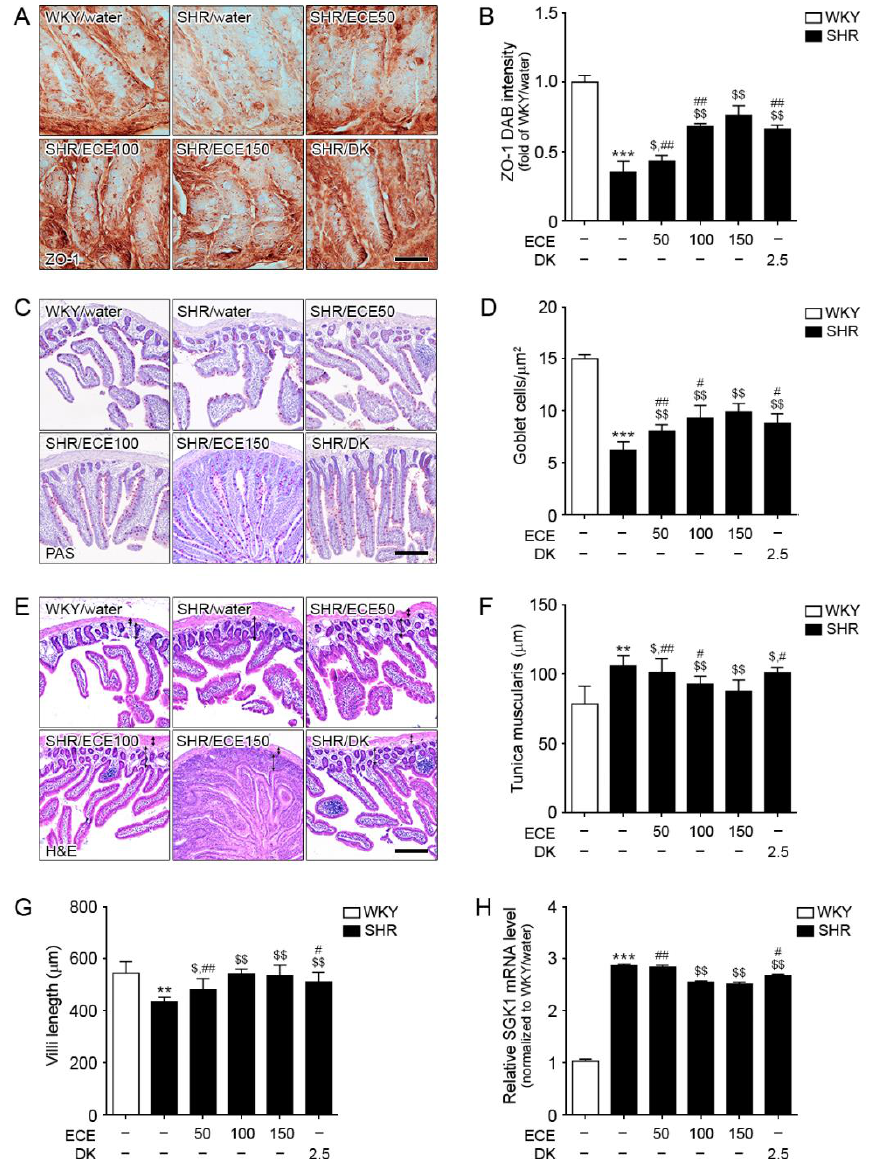
Figure 2. Regulatory effects of DK and ECE on the destruction of gut barrier integrity and SGK1 level in the intestine of SHRs. ( A , B ) The ZO-1 expression level in intestinal tissues was decreased following SHR/water and increased following ECE or DK treatment. ( C , D ) The number of goblet cells in intestinal tissues was decreased following SHR/water and increased following ECE or DK treatment. ( E – G ) The tunica muscularis thickness and villi length in intestinal tissue were measured by H&E staining. ( H ) In intestinal tissues, SGK1 mRNA levels were increased following SHR/water. The addition of ECE and DK decreased the SGK1 mRNA level. For each of the 6 groups, n = 5. Scale bar = 100 µ m. **, p < 0.01 and ***, p < 0.001, vs. WKY/water; $, p < 0.05 and $$, p < 0.01, vs. SHR/water; #, p < 0.05 and ##, p < 0.01, vs. SHR/ECE150 (Mann–Whitney U test). DK, dieckol; ECE, Ecklonia cava extract; HE, hematoxylin and eosin staining; PAS, periodic acid–Schiff; SGK1, serine/threonine-protein kinase; SHR, spontaneously hypertensive rat; WKY, Wistar Kyoto rat; ZO-1, zonula oc- cludens-1.